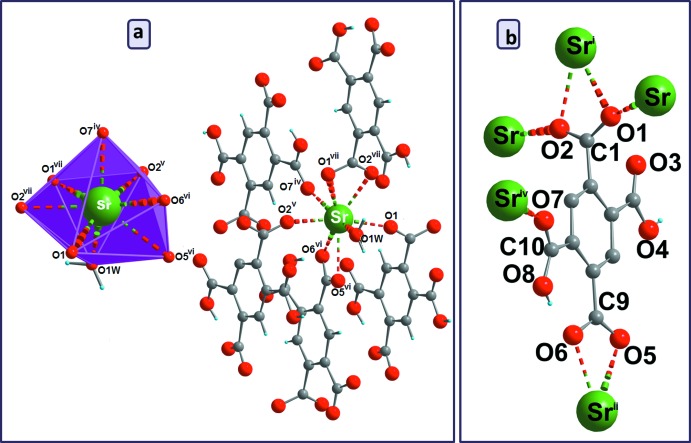
(a) Perspective view of the coordination environment of SrII and (b) coordination modes of the (H2BTEC)2– anion in (I). [Symmetry codes: (i) x, −y + 2, z − ; (ii) x, −y + 1, z − ; (iv) −x + , −y + , −z + 2; (v) x, y, z + 1; (vi) x, −y + 1, z + ; (vii) x, −y + 2, z + .]